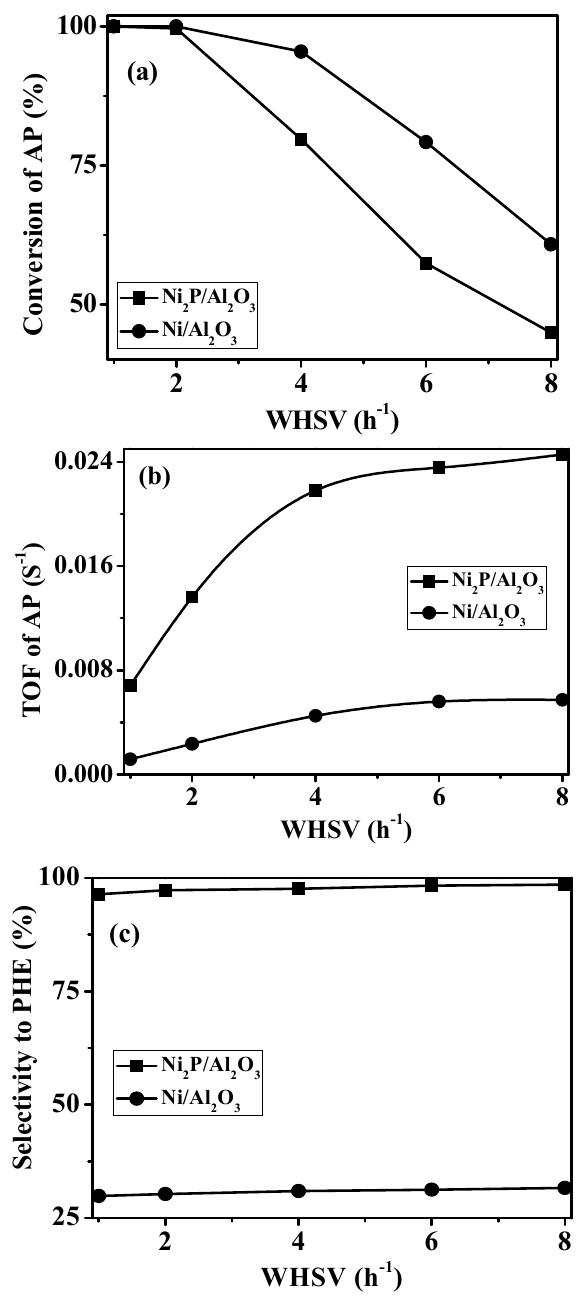
Figure 8. Conversions ( a ), turnover frequencies (TOF) ( b ) of AP and selectivity to PHE ( c ) vs. WHSV of AP over the Ni/Al 2 O 3 and Ni 2 P/Al 2 O 3 catalyst. Reaction conditions: p = 3.0 MPa, H 2 /AP = 5, T = 433 K.